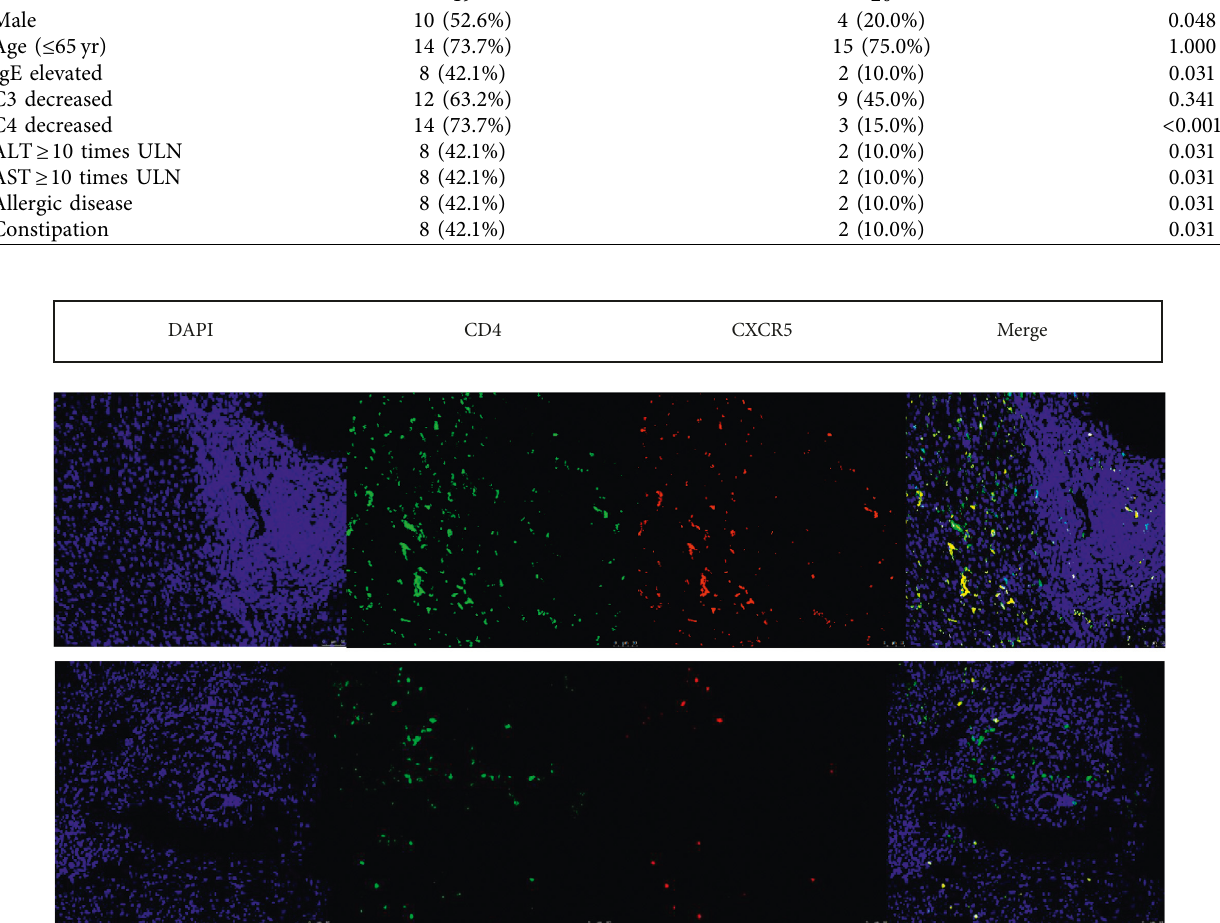
Figure 2: (a) Abundant intrahepatic Tfh infiltration in AIH patients with elevated serum IgG4. (b) Sparse intrahepatic Tfh infiltration in AIH patients with normal IgG4 level. Tfh localization was assessed by immunostaining and fluorescence microscopy: nuclei were stained with DAPI (blue), CD4 (green), CXCR5 (red), and the DAPI, CD4, and CXCR5 images were detected after glucocorticoid therapy, with routine appli- ( P � 0 . 0002; Figure 4(b)), ALKP ( P � 0 . 0002; Figure 4(c)), cation of the hepatoprotective drugs dicyclool and mag- Figure 4(d)), TBil ( P � 0 . 0011; nesium isosidooxalate. Figure 4(e)), and DBil ( P � 0 . 0003; Figure 4(f)) were